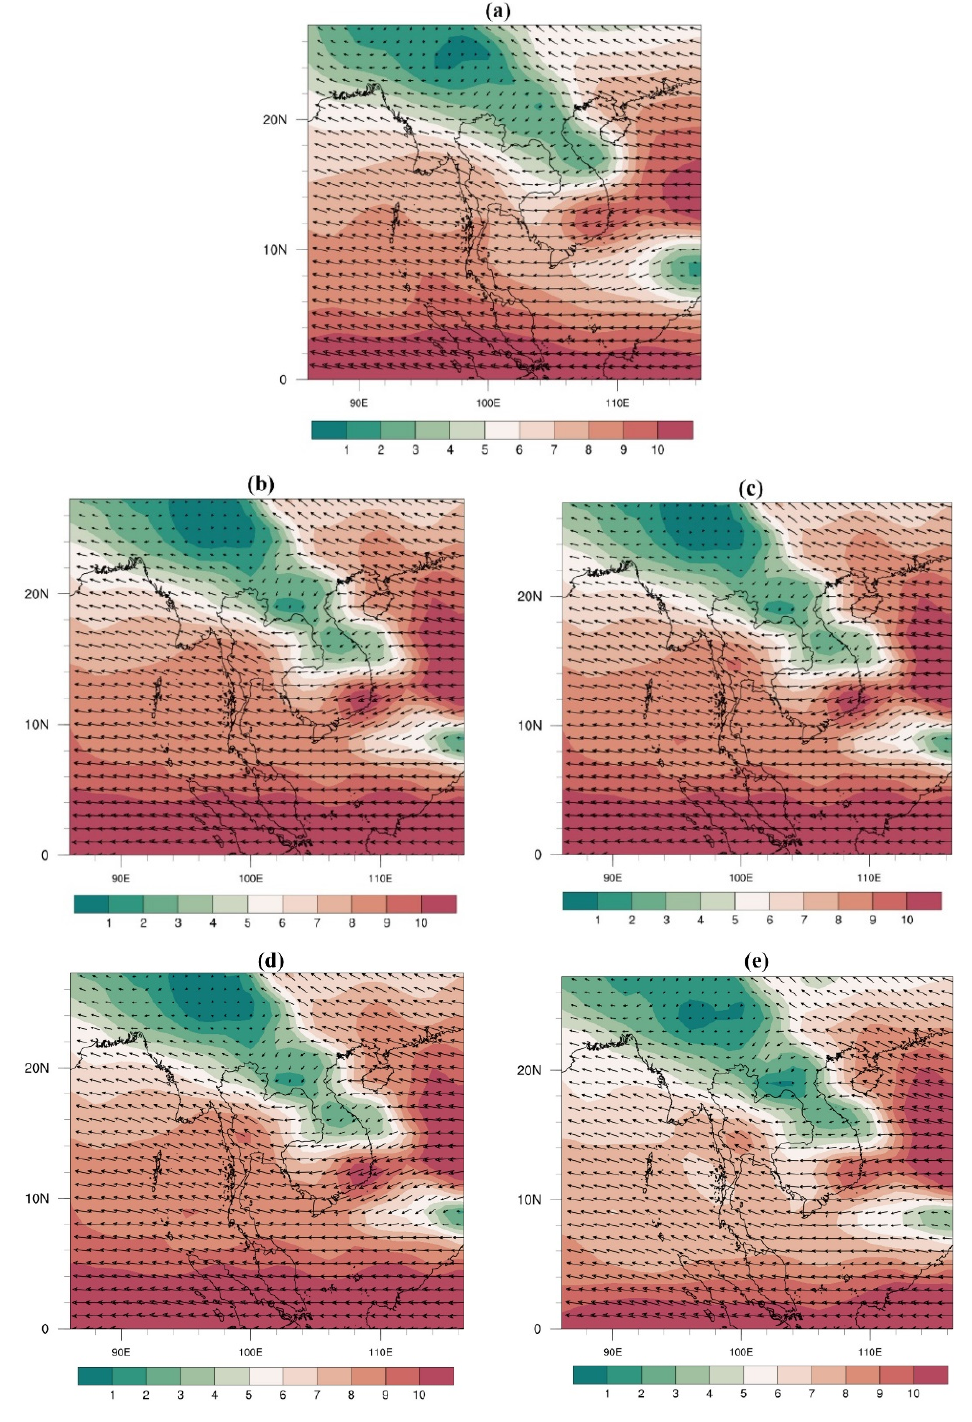
Figure 6. The 850 hPa circulation including wind field (vector, unit: m/s) at 00 UTC on 23 September 2021: ( a ) NCEP FNL analysis, ( b ) ALL-OBS, ( c) RDA1, ( d ) RDA2, and ( e )